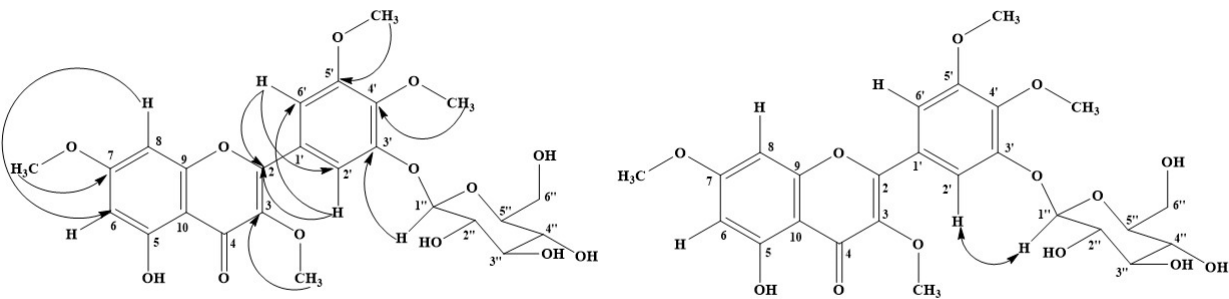
Figure 3. HMBC (on the left) and NOESY (on the right) correlations of compound 5